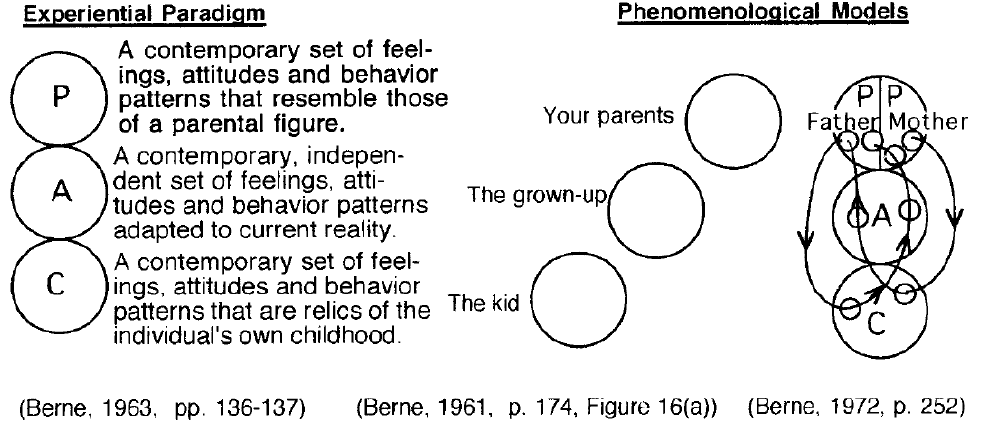
Figure 10: From Experiential Paradigm to Phenomenological Models (Drego, 1993,